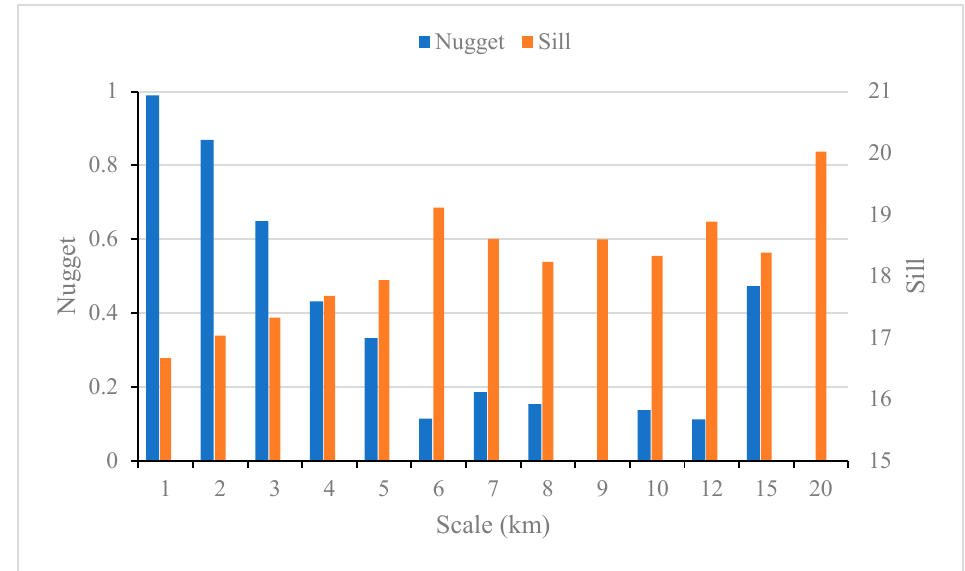
Figure 2. Nugget and sill at different scales.